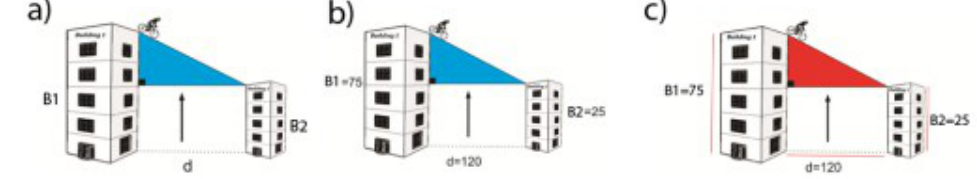
Figure 4. Remediaton for queston 3: a) used afer 1st unsuccessful atempt, b) used afer 2nd unsuccessful atempt and c) used afer 3rd unsuccessful atempt